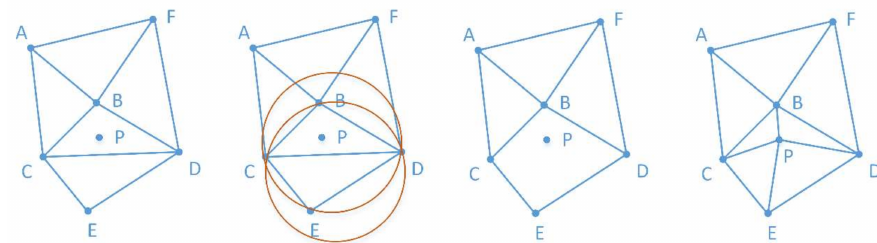
Figure 6. Delaunay triangulation principle.